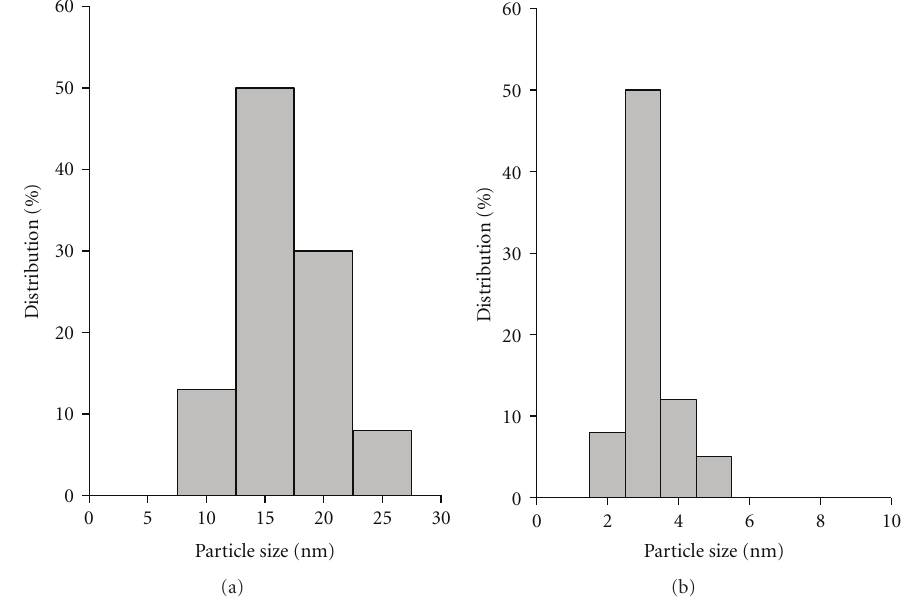
Figure 4: Size distribution diagrams of Pt metal obtained from the TEM images of the Img: Pt-ZnO-SiO 2 (a) and PAD: Pt-ZnO-SiO 2 (b)